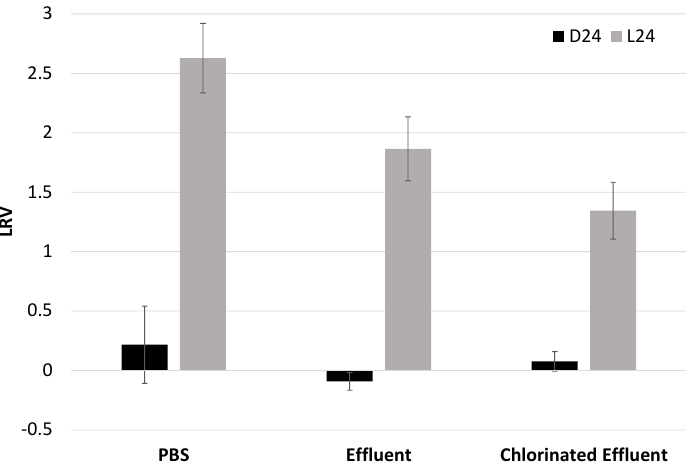
Figure 3. Log reduction values of the binding affinity of dark-control viruses (D24) and solar-irradiated EV70 (L24) with respect to untreated EV70. Y -axis represents log reduction value (LRV) with respect to nontreated EV70. D24: dark-control EV70 viruses that were placed in the solar simulator for 24 h but kept in the dark. L24: EV70 viruses that were exposed to simulated solar irradiation for 24 h. The irradiance rate at 280–700 nm was 28 J/cm 2 /h. PBS, n = 3; effluent, n = 2; chlorinated effluent, n =